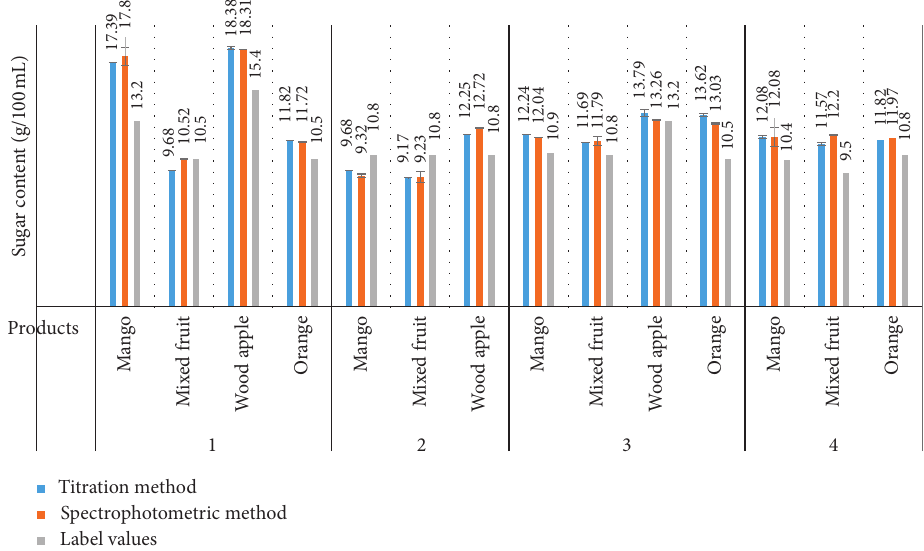
Figure 7: Comparison of the titration method values and spectrophotometric method (colorimetric method) values with products label values. Table 3: Behavior of standard synthetic colors on TLC with n -butanol: water:glacial acetic acid (20:12:10 v/v) solvent system. Color standard R f value Color of the spot Carmosine 0.79 Dark strawberry red Ponceau 4R